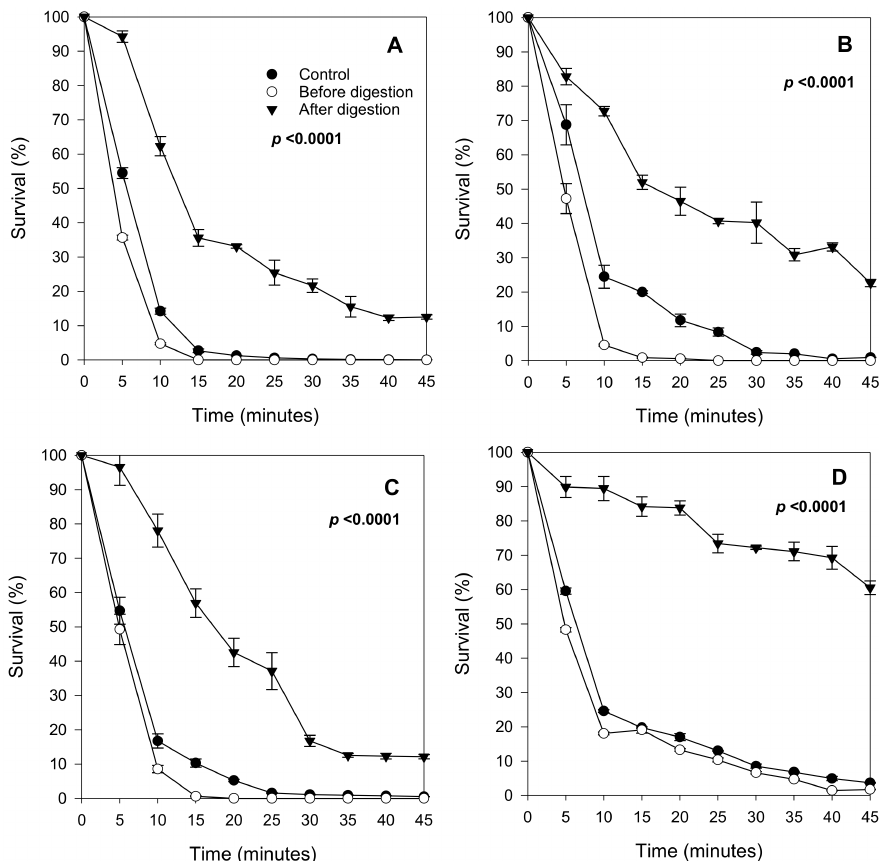
Figure 3. Survival curves of S. cerevisiae SKQ2n treated with H 2 O 2 (0.45 M) cultured in YNB with 2% glucose without berry extracts (Control), with berry extracts before in vitro digestion (before) and after in vitro digestion (After). ( A ) = bilberry, ( B ) = black currant, ( C ) = raspberry and ( D ) = strawberry. Significant differences between treatments were detected using Tukey’s Studentized Range (HSD) test at the 5% level of significance (see also suplementary materials Table S1). Data points are averages of replicated samples from three separate (independent) stress assays ( ± SE).